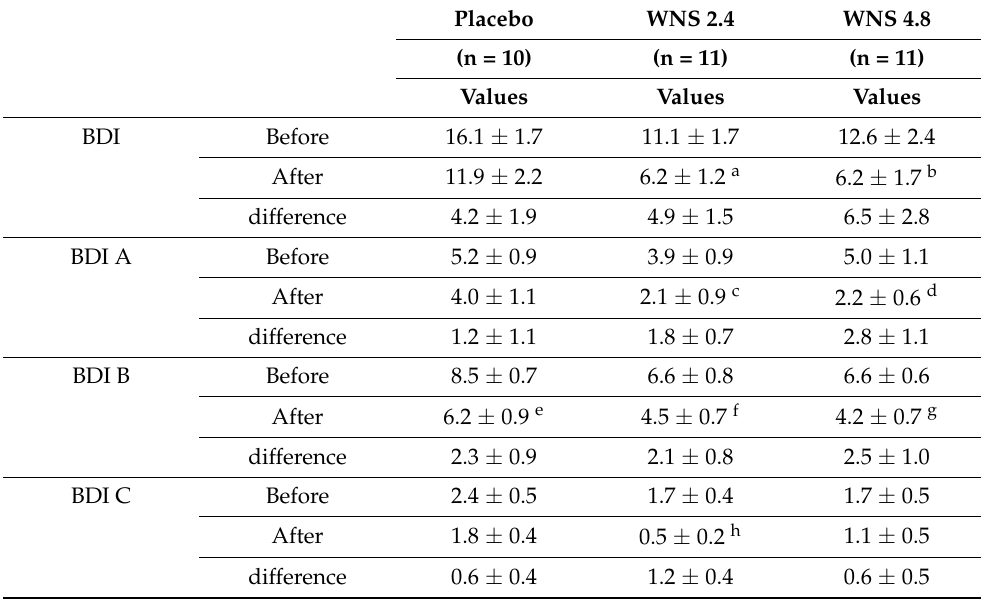
Figure 1. The study flowchart. Table 2. Changes in total BDI scores and BDI subscale scores in patients after WNS treatment for two Table 1. Characteristics of randomized subjects.